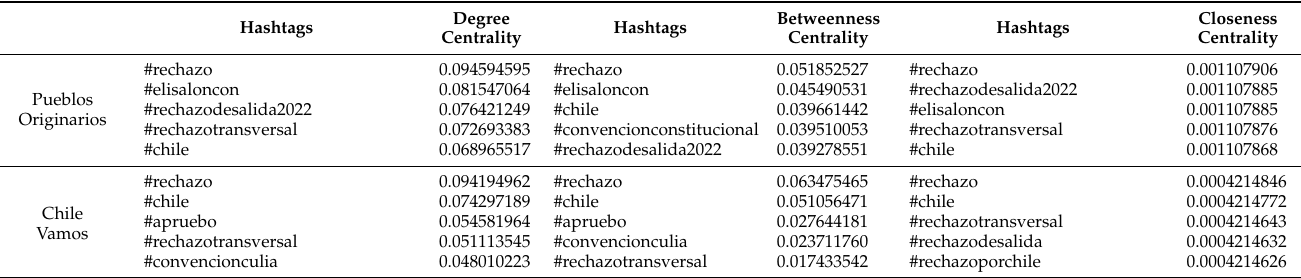
Figure 3. Network of hashtags with hate speech for Lista del Apruebo 2022. In the network of hashtags of the Lista del Apruebo representatives, the presence of messages alluding to rejection is central but less dense than in the Apruebo Dignidad net- work, for example. The allusions to approval are found in the lower part of the graph, in a dispersed and not very dense manner. An interesting aspect that appears in this network is a nucleus with hashtags that formulate the concept “recapacitar” (please reconsider) in various ways. These hashtags integrate the names of women, alluding to their extreme positions they took within the Convention. Other hashtags that appear and that could be qualified